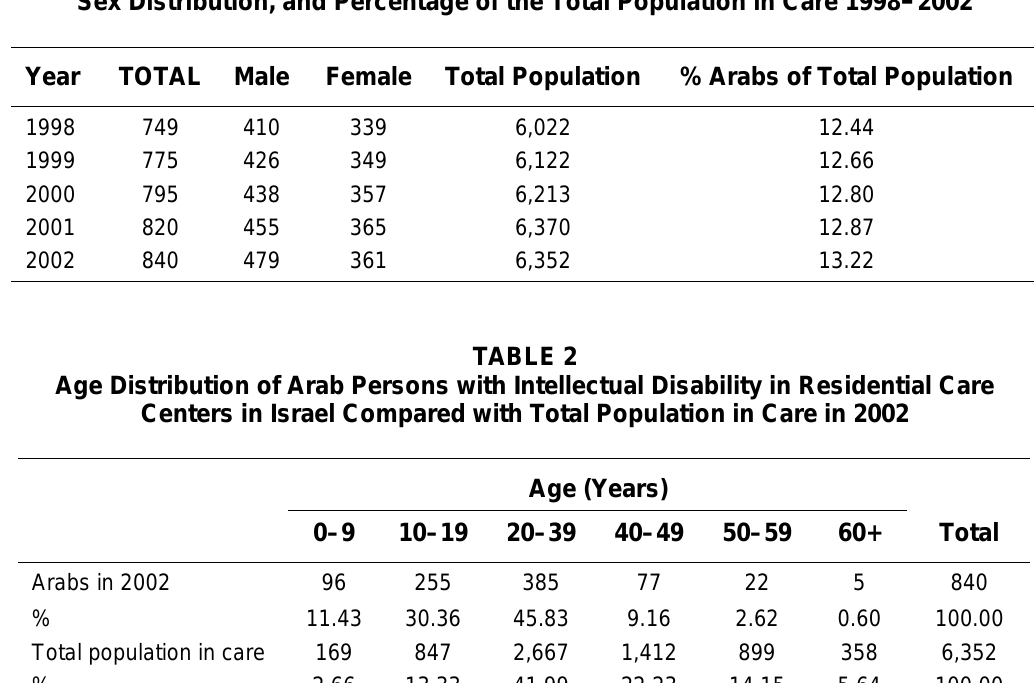
Number of Arab Persons with Intellectual Disability in Residential Care Centers in Israel, Sex Distribution, and Percentage of the Total Population in Care 1998 – 2002